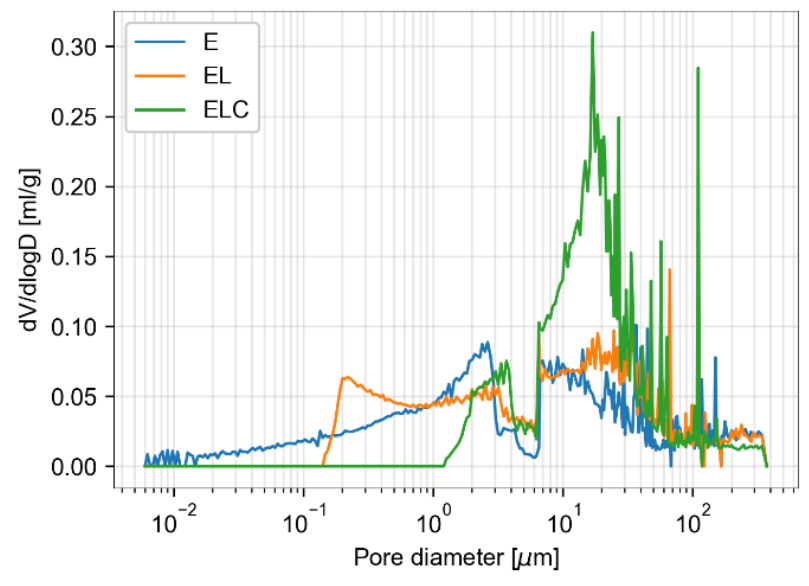
Figure 36. Distribution of pore size of the hardened mortars. shrinkage of the ELC mixture is several times greater than in the other two types of mortar.